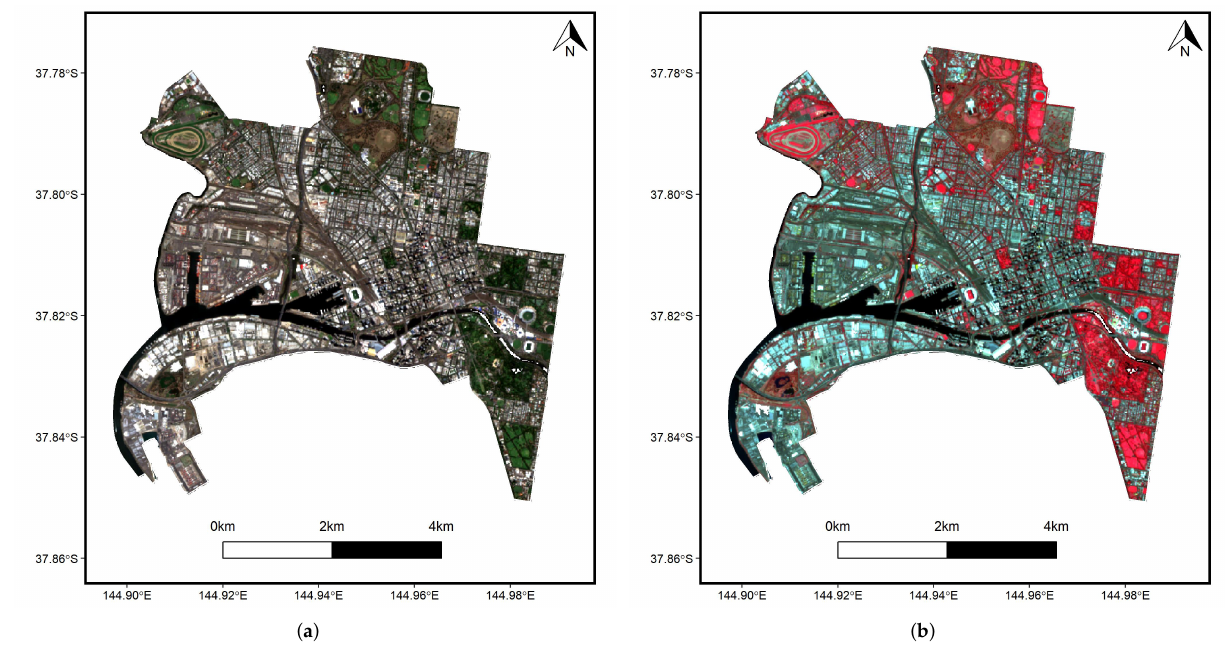
Figure 4. Red Green Blue (RGB) Sentinel-2A image ( a ) and False Colour Sentinel-2A image ( b ) of the City of Melbourne, Victoria, Australia.